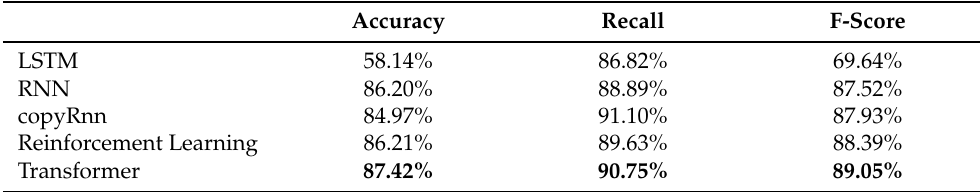
Table 6. Accuracy, recall and F-score of the five basic